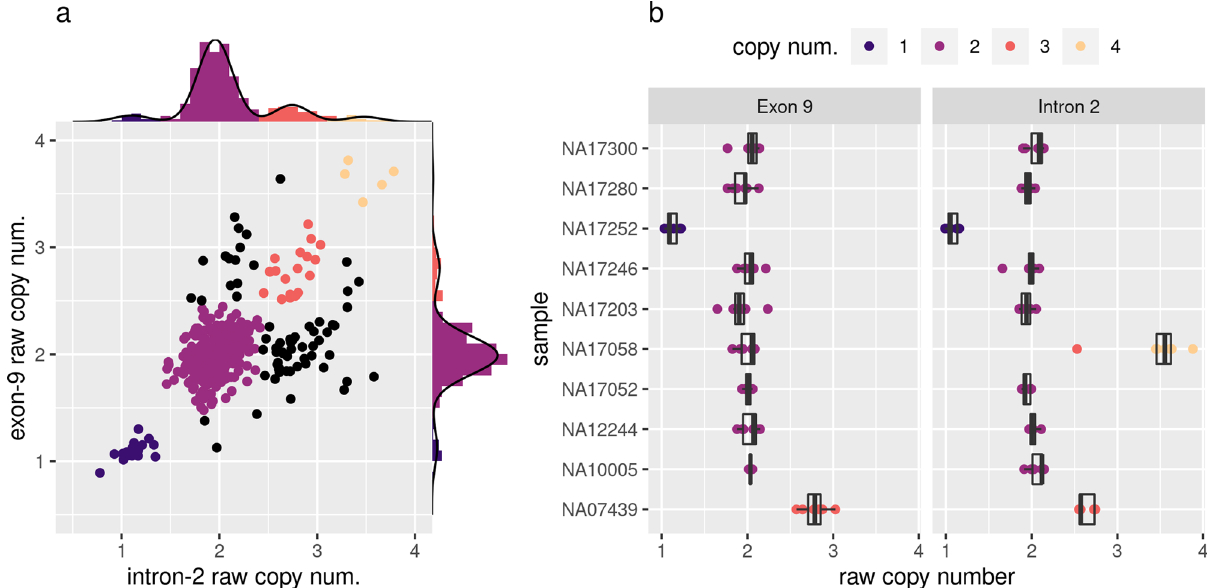
Fig. 1 CYP2D6 intron-2 and exon-9 qPCR results. a Scatterplot showing raw copy numbers for intron-2 and exon-9 qPCR assays for the Solomon Islands Cohort. Axis margins show histograms overlaid with the density from the Gaussian mixture models used to assign copy number states; b Tukey boxplots of raw copy number for control sample technical replicates repeated over several qPCR runs. Shown are seven technical replicates for all samples/markers except NA10005/Exon-9, NA17300/Exon-9, and NA17246/Intron-2 where only six were available, and NA12244/Intron-2 where only four were